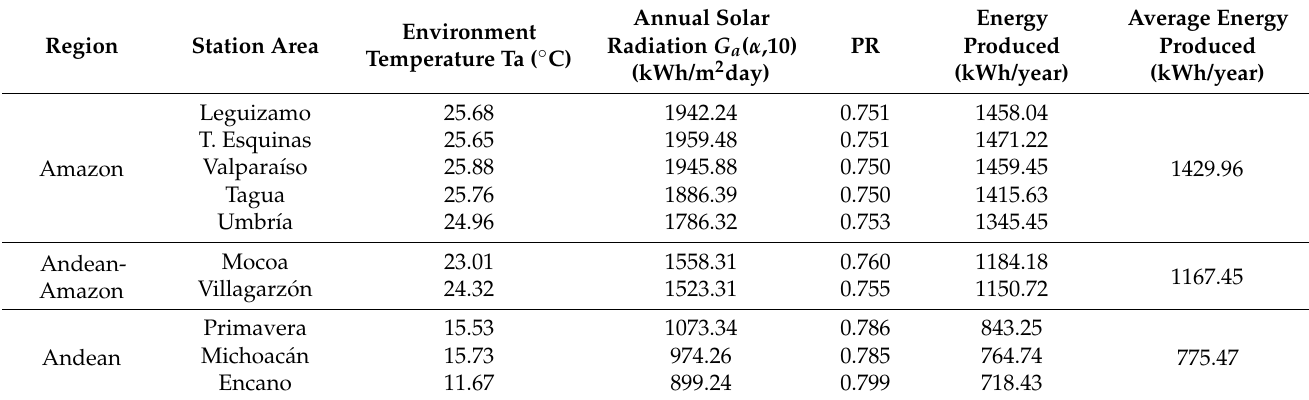
Table 6. Solar irradiation on inclined surface and energy production with a solar system of 1 kWp in optimal conditions.